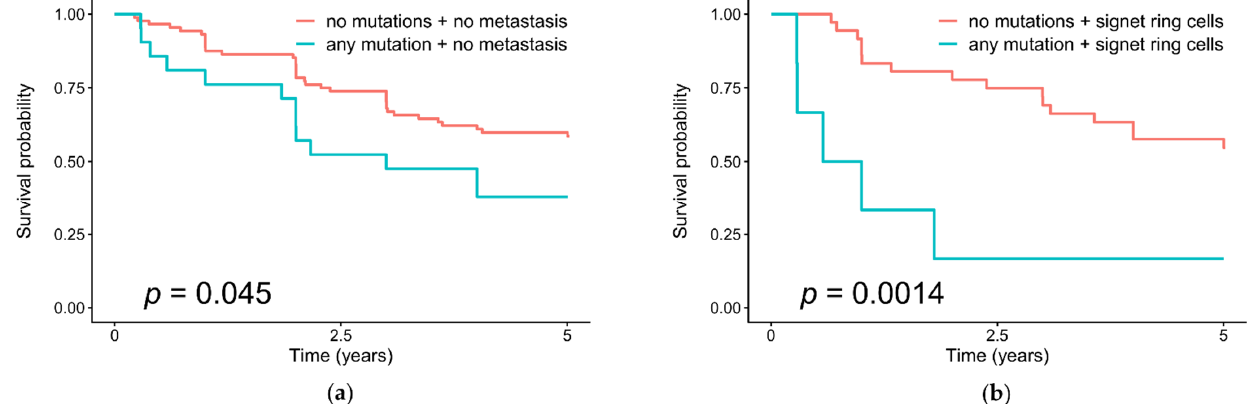
Figure 3. Overall survival in patients with and without somatic mutations of the chromatin remodeling genes in their gastric tumors, and ( a ) with distant metastases; ( b ) with the presence of signet ring cells in tumors.